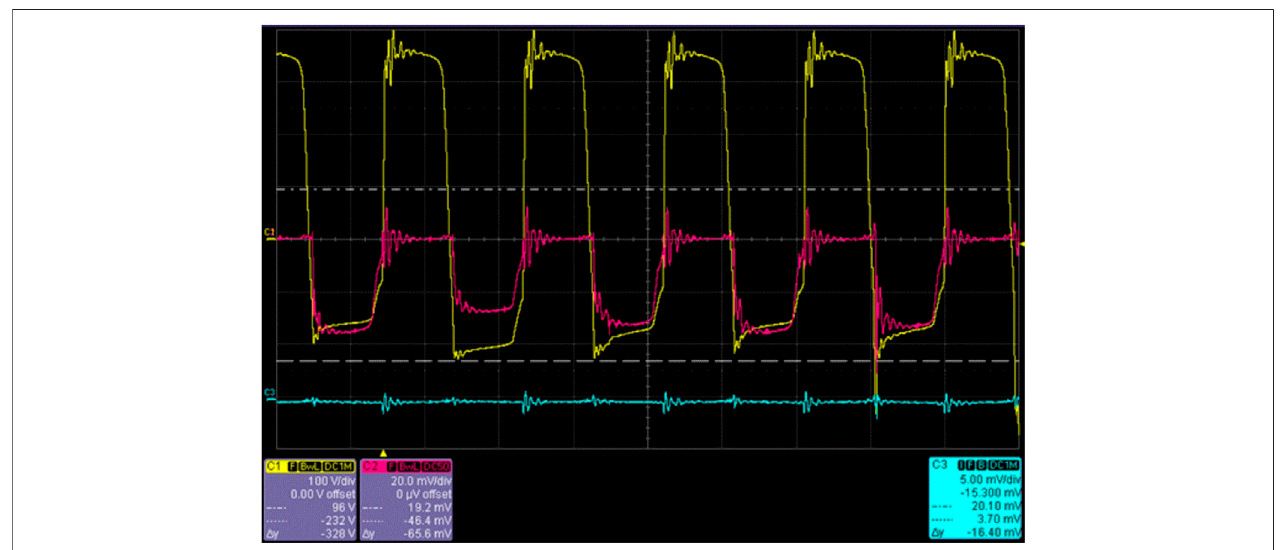
FIGURE 1 | Voltage (yellow curve), current (red curve), and plasma glow (blue curve) oscillograms of the active electrode.